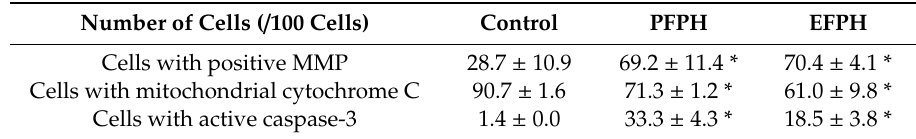
Table 2. Percentage of Caco2 / CT7 cells with a positive mitochondrial membrane potential. Cells with mitochondrial cytochrome C and active caspase-3, quantified by flow cytometry in response to fenugreek proteins hydrolysates treatment (24 h).